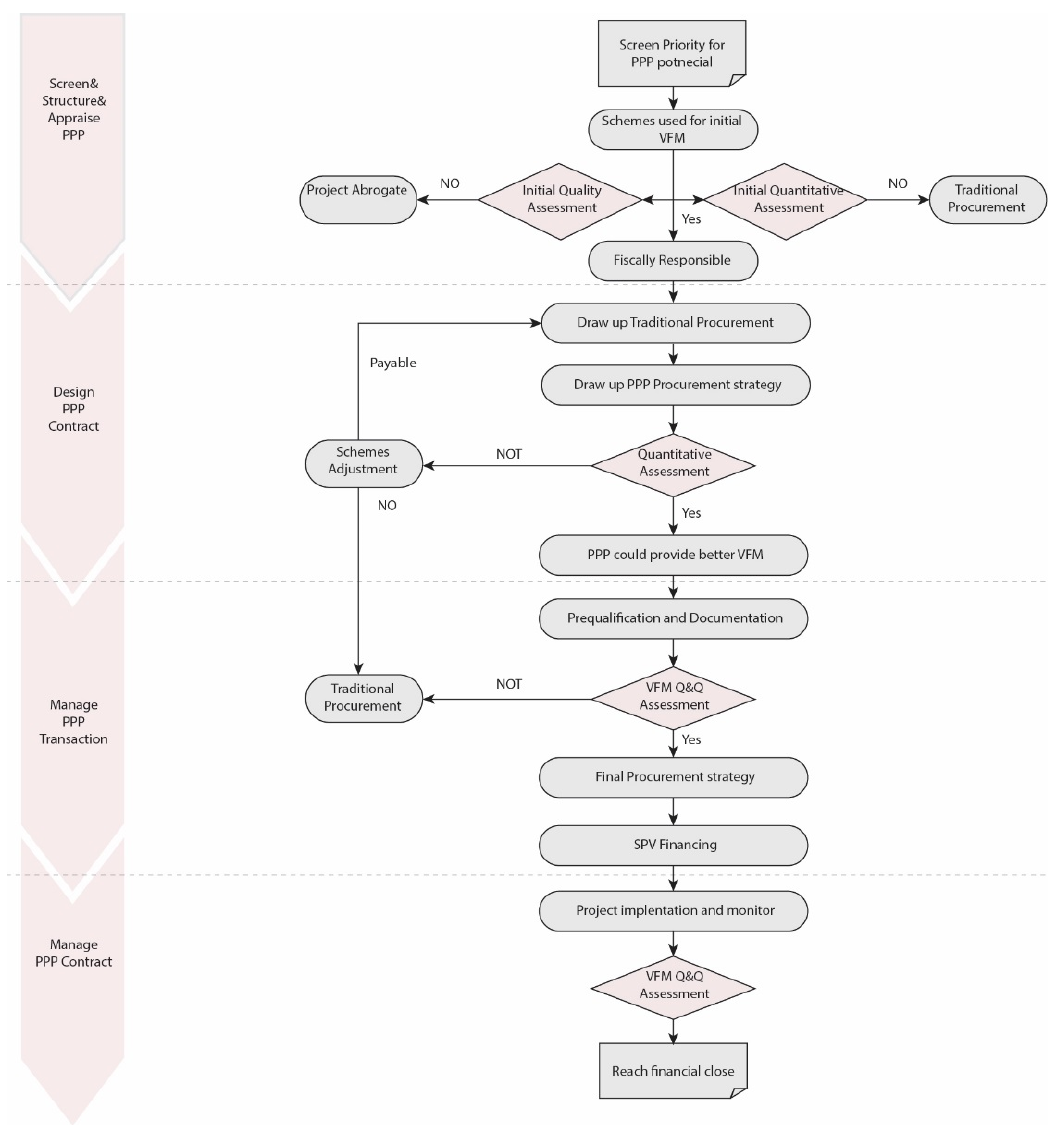
Figure 4. The VfM process through the project lifecycle.